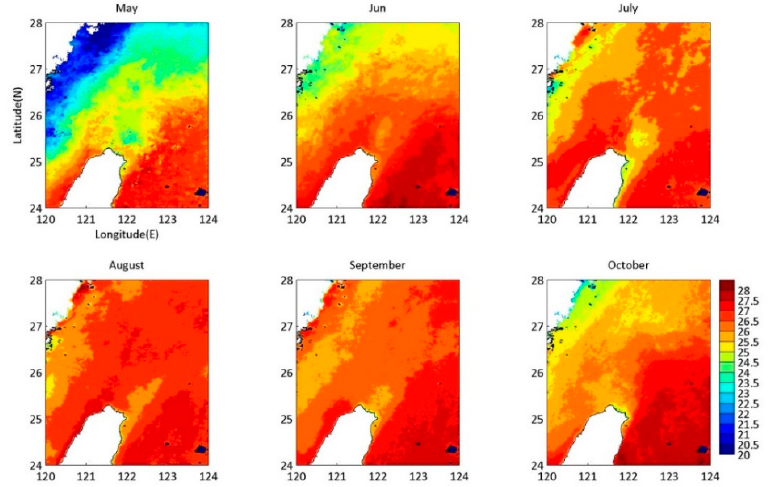
Figure 3. Monthly climatological sea surface temperatures ( ◦ C, averaged from 1993 to 2013) from May to October.